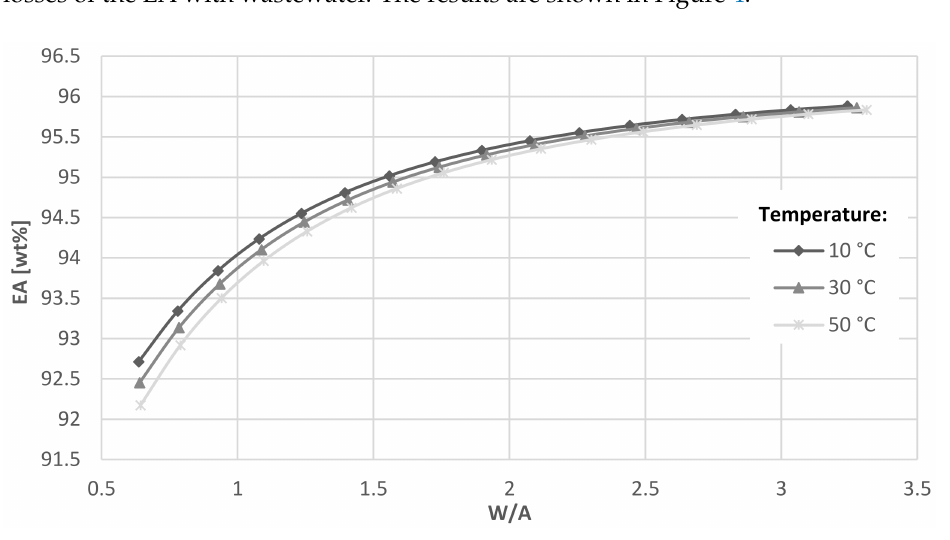
Figure 4. The influence of temperature and water/azeotrope ratio on the EA content in the organic